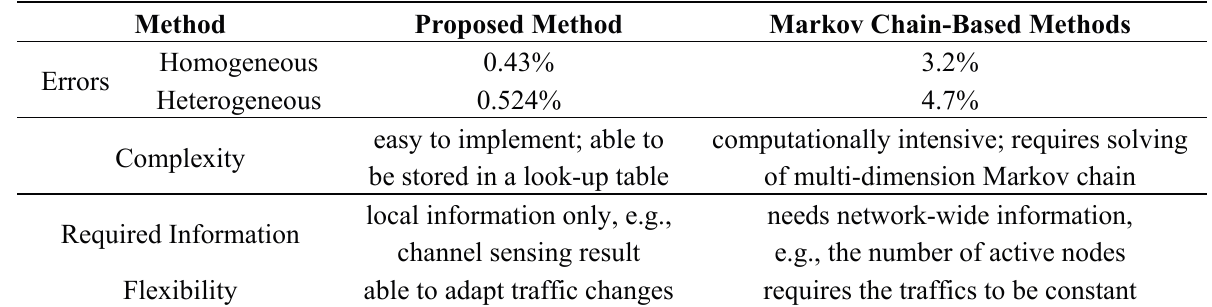
Table 1. Comparisons of the proposed method and the Markov-chain based Methods.